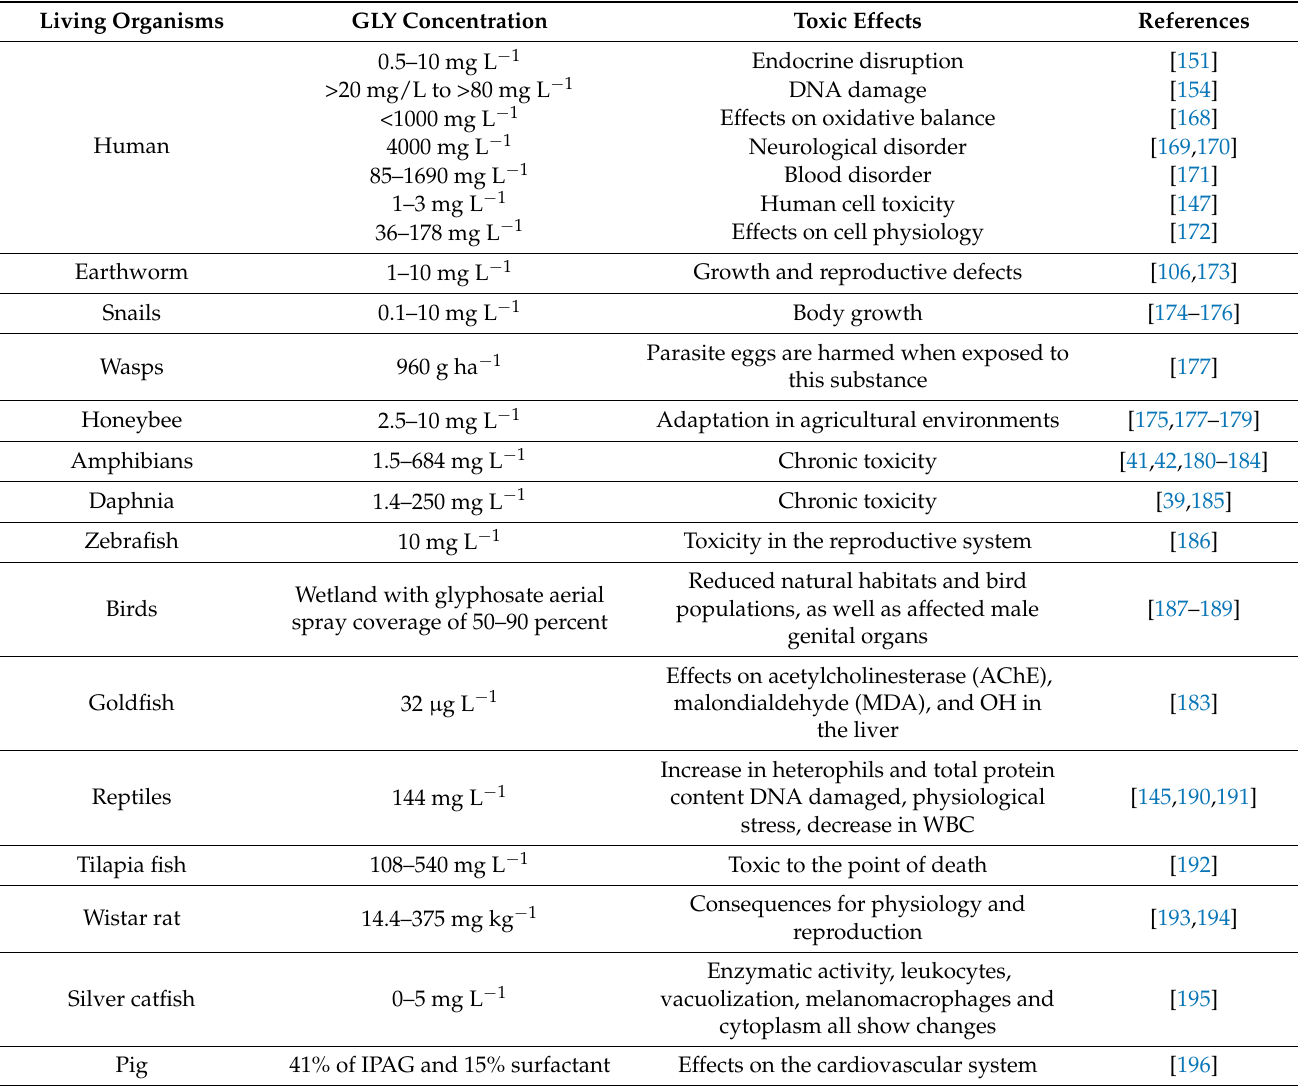
Table 3. The toxicity of glyphosate-based herbicide formulations to a variety of living